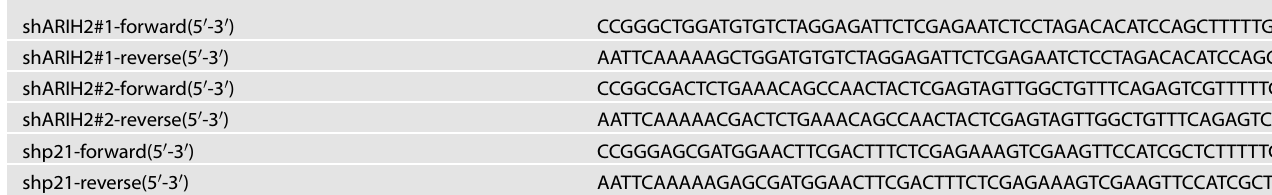
Table 1. Primers of shRNA.